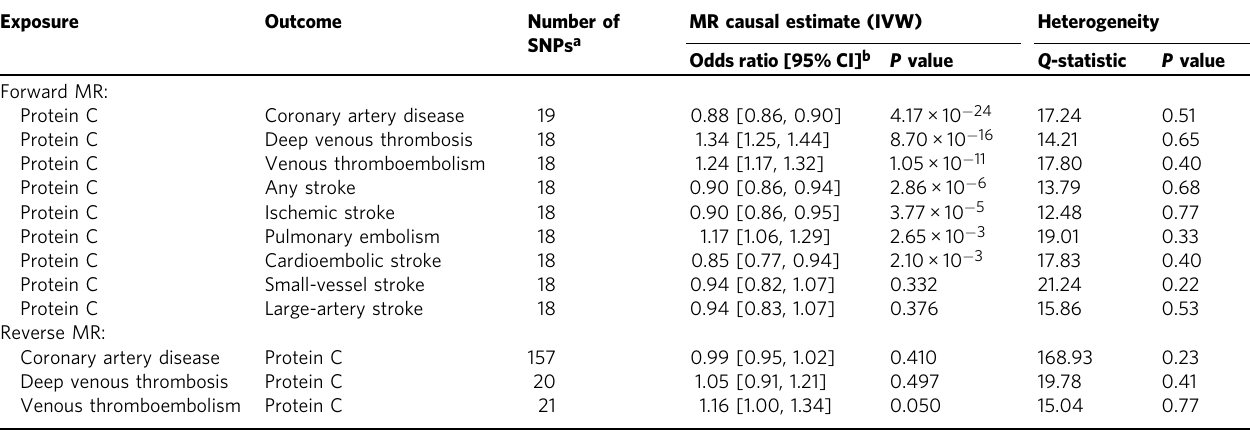
Table 1 Mendelian randomization estimates for the effect of genetically determined levels of protein C on the risk of vascular diseases and